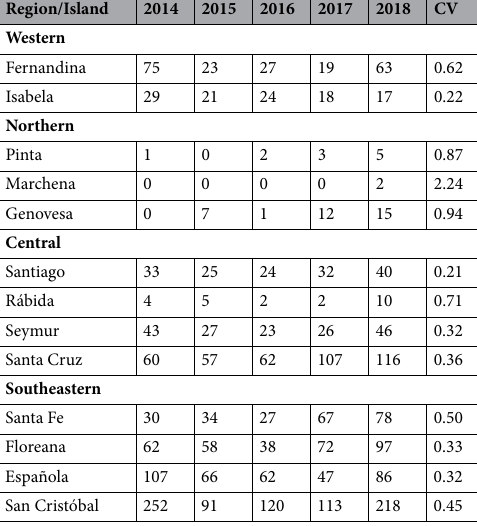
Table 2. Galapagos sea lion pups counted in breeding rookeries throughout the archipelago. The coefficient of variation (CV) shows the variability in the number of pups counted per island throughout the